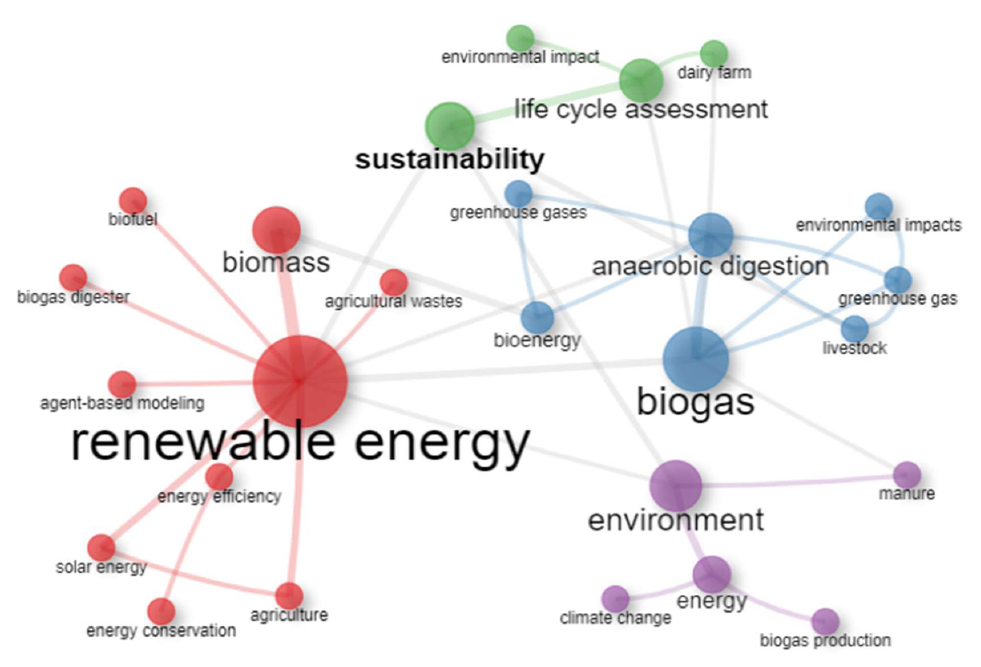
Figure 4. Keyword co-occurrence network (1988–2022). Source: created by the authors. The blue cluster with the “biogas” keyword is the main one in this category, the pur- ple cluster with the category of the environment (including manure, energy, climate change), and the remaining green cluster with just four keywords out of 30 (sustainability, life cycle assessment, environmental impact, and dairy farm) and overlapping with the blue cluster, it proves that biogas is that on-farm renewable energy source, which has been mostly searched among the RES and its environmental effects has been highlighted in the research. It is referred to as clean or “green” energy, produced from sources that do not run out or can be replenished, with a special aspect: environmental consciousness and waste management. It also shows that “anaerobic digestion” is a more frequently used keyword than “bioenergy.” As per Massé et al. (2011) [102], anaerobic digestion is one of